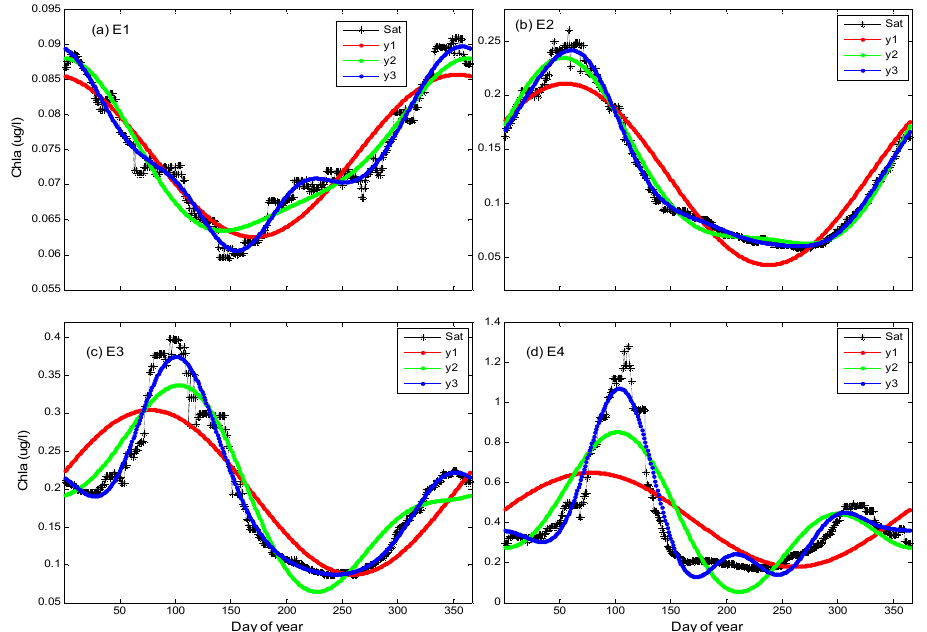
Figure 9. Comparison of satellite Chl-a (marked as Sat) with the fitted values of three sine equations (marked as y1, y2, and y3) at the four sites (E1–E4, positions shown in Figure 8b). ( a ) The site of E1 (22.0 °N/159.0 °W) is selected for Class 1, ( b ) E2 (32.6 °N/169.0 °W) for Class 2, ( c ) E3 (34.8 °N/165.2 °E) for Class 3, and ( d ) E4 (38.2 °N/135.6 °E) for Class 4.